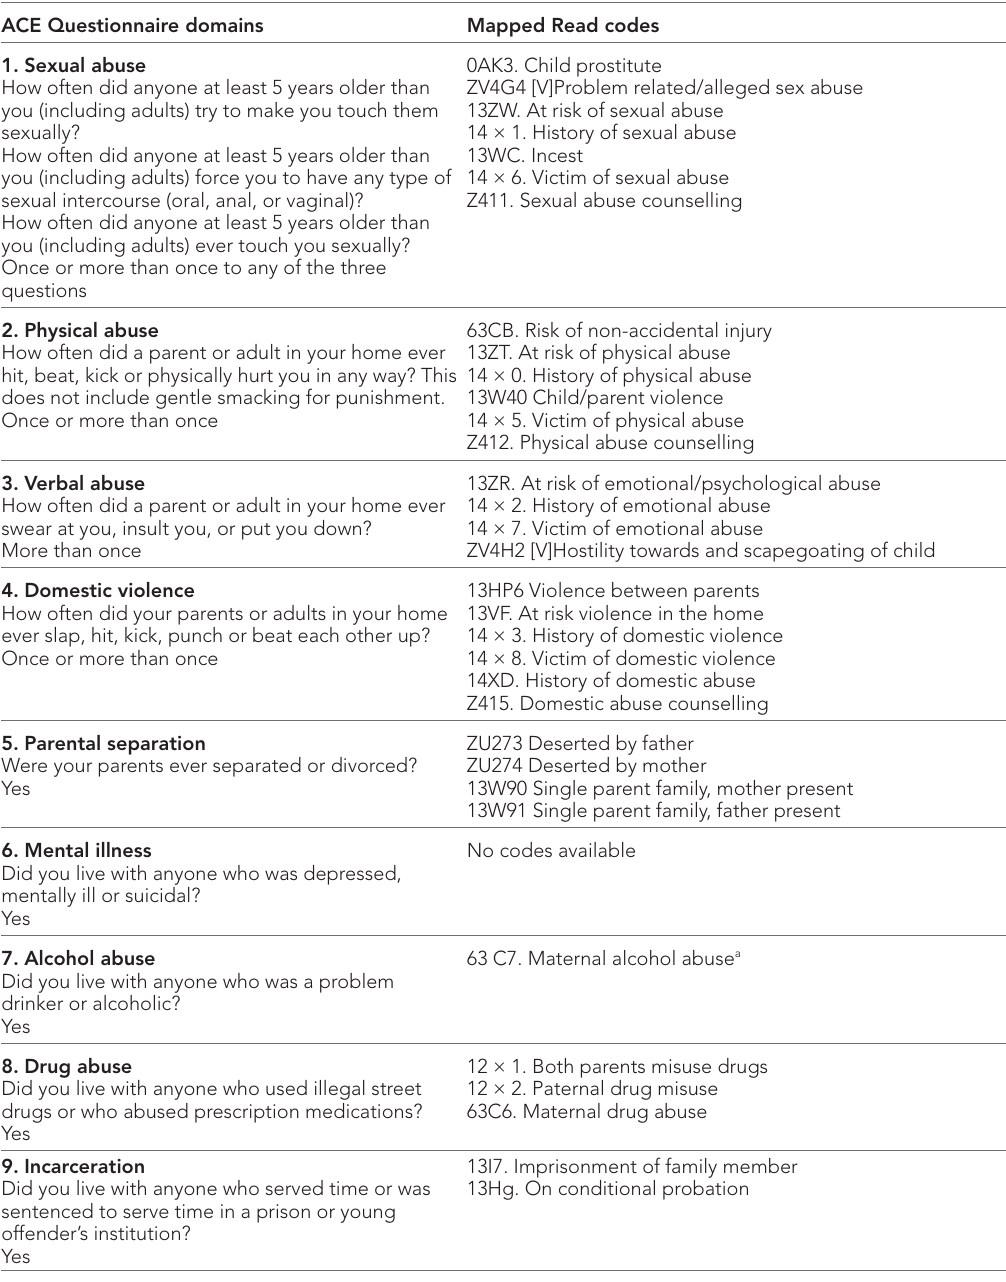
Table 1 ACEs mapped to Read codes included in the study. All ACE questions were preceded by the statement ‘While you were growing up, before the age of 18